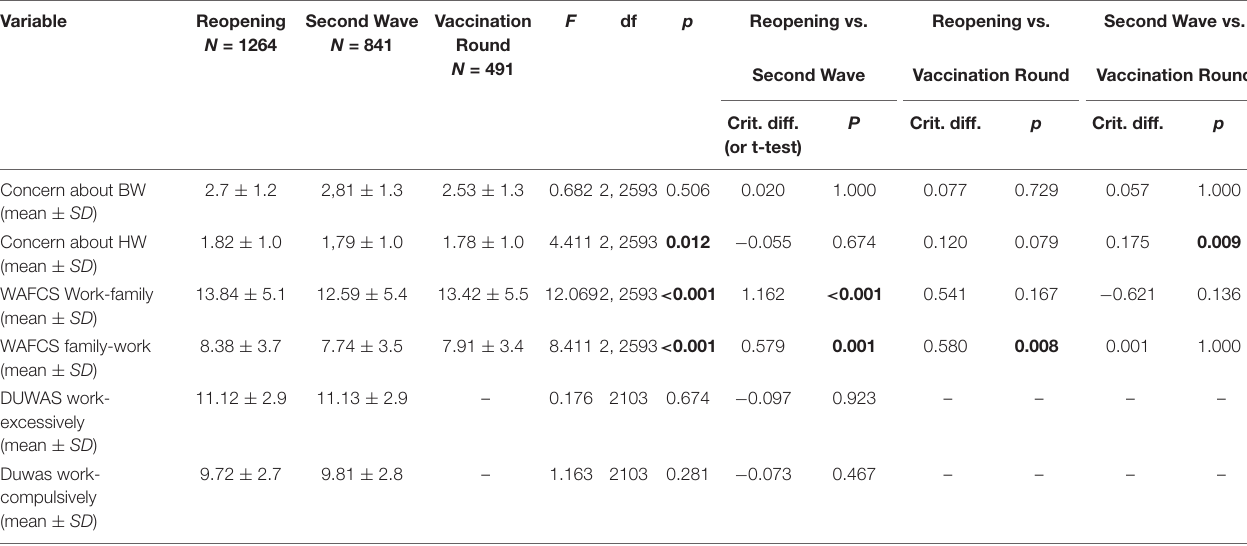
TABLE 2 | Questionnaires scores in Reopening, Second Wave, and Vaccination Round groups. Variable